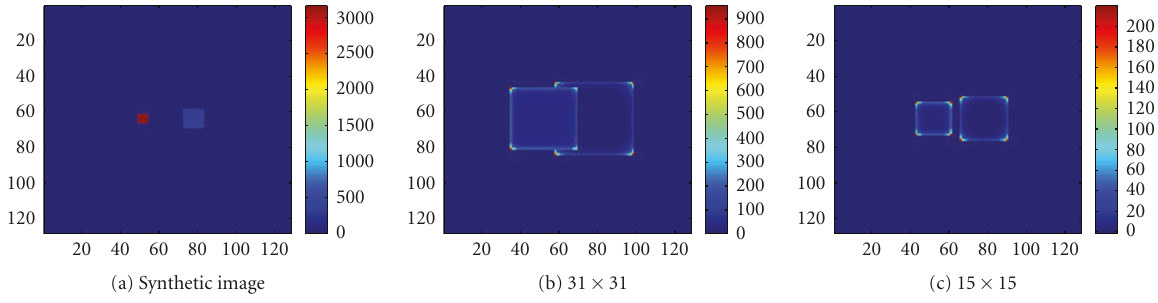
Figure 11: Kurtosis images obtained with di ff erent sizes of window on a synthetic image with two regions (left object: SNR = 70 dB, right object: SNR = 50dB).